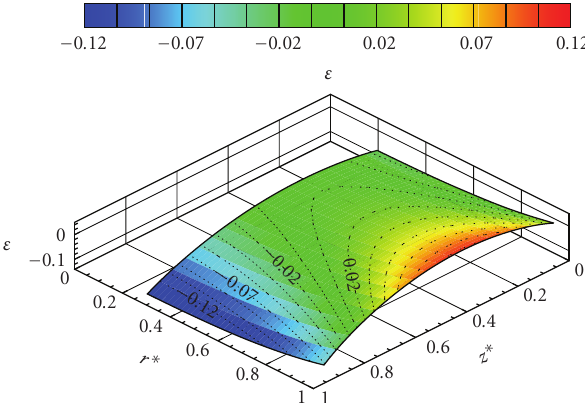
Figure 3: Axial and radial distribution of ε in test case A.